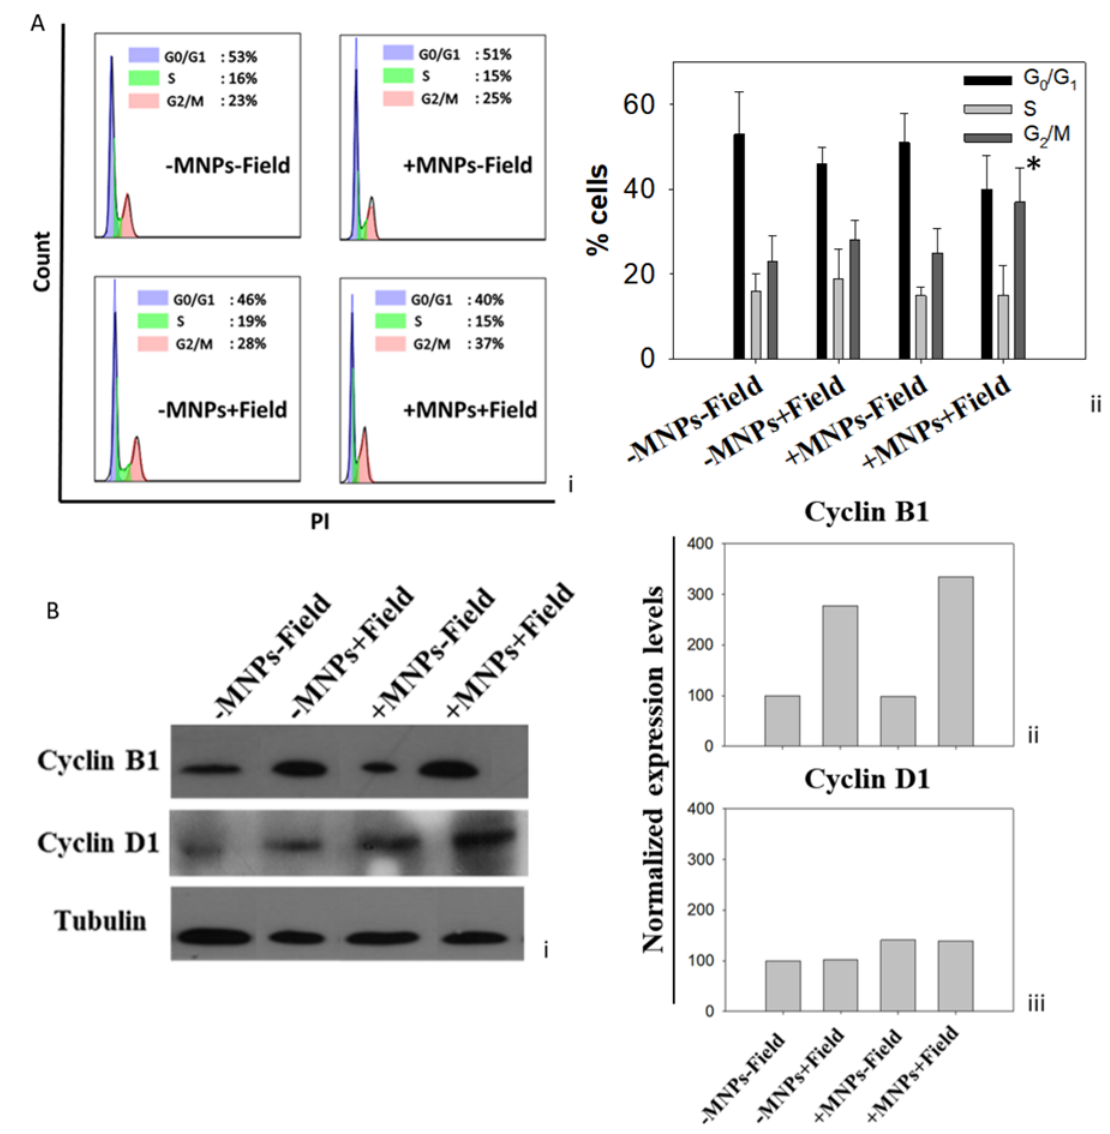
Figure 3. Effect of magnetic field exposure on cell cycle. ( A ) Cell cycle analysis after magnetic field exposure. HT29 cells were treated with MNPs, synchronized, and/or exposed to a static magnetic field of 200 mT. Flow cytometry analysis was performed 24 h post magnetic field exposure. ( Ai ) Flow cytometry histograms are representative of four independent experiments. ( Aii ) The data are presented as the means ± SD of three independent experiments. * Asterisk indicates statistical significance compared to the control ( − MNPs −Field) group, Student’s t -test, p = 0.031. ( B ) Expression of cyclin B1 and cyclin D1. ( Bi ) Western blot analysis of cyclin D1 and cyclin B1 expression levels in ±MNPs±Field HT-29 cells. Cells were treated with MNPs and/or exposed to a static magnetic field of 200 mT. Cells were collected and lysed 24 h post magnetic field exposure. Densitometry analysis of the immunostaining results. Expression of cyclins ( Bii ) B1 and ( Biii ) D1 is presented as a normalized fold change compared to control ( − MNPs − Field) expression levels (100%). Results presented are representative of two independent experiments. Tubulin was used as the normalization control.